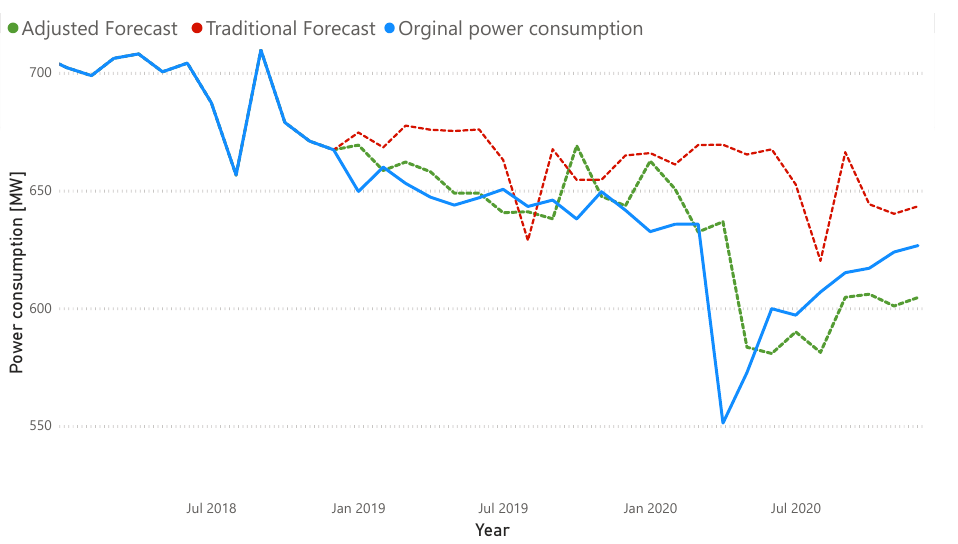
Figure 13. Adaptive and traditional models against actual power consumption.